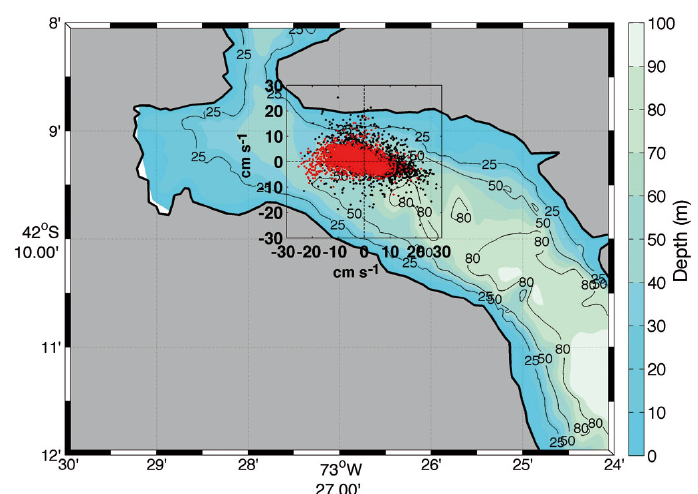
Fig. 2. Surface (black dots) and bottom (red dots) scatter plots of the total current in Caucahue Channel, 17 April to 21 July 2011